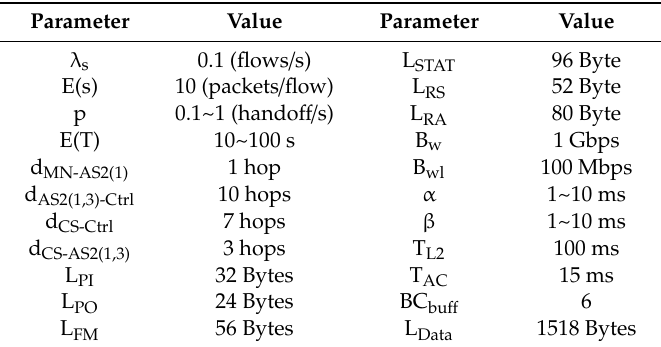
Table 3. Parameter values.